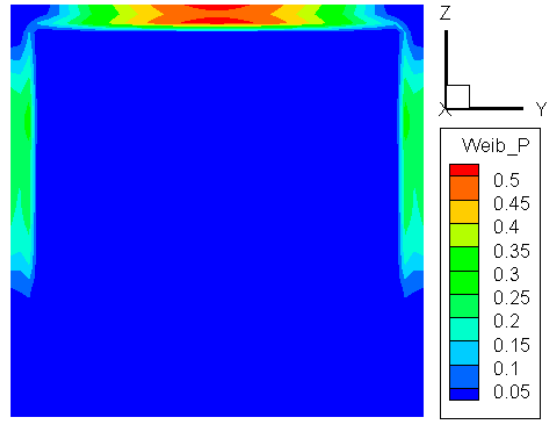
Figure 3. Probability distribution of crack initiation via the two-parameter Weibull distribution.